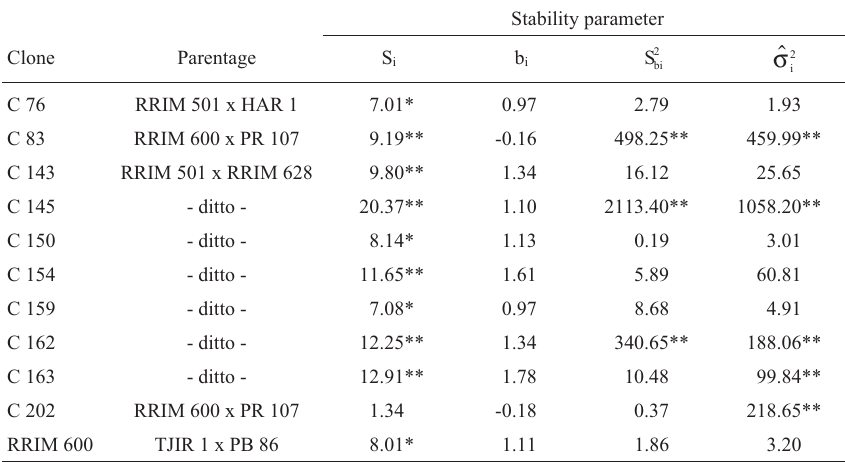
Table 2 - Clonal stability parameters of tree dryness in Hevea brasiliensis